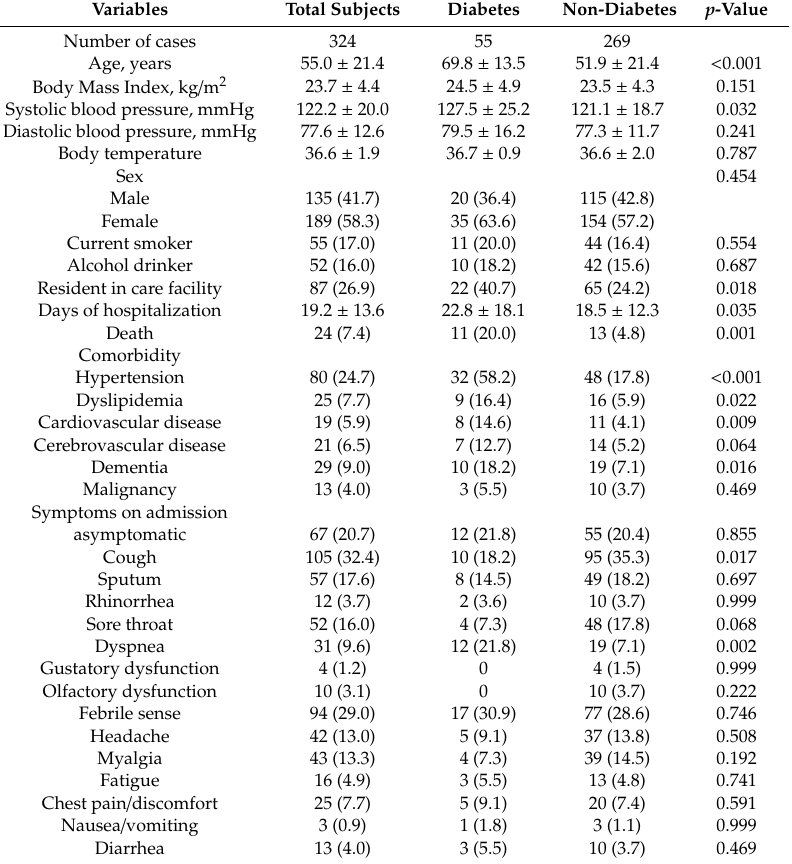
Table 1. General characteristics of the study